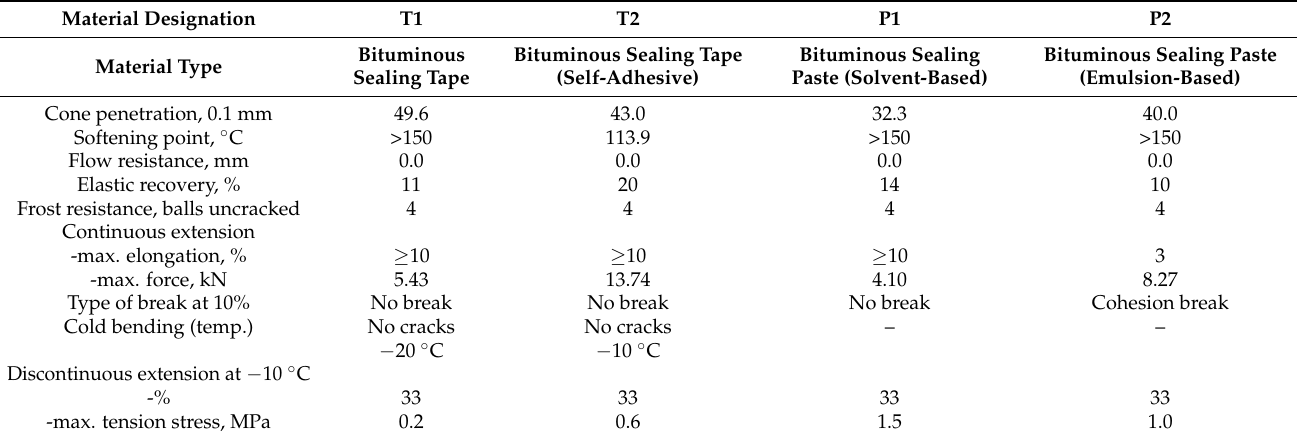
Table 5. Characteristics of sealing